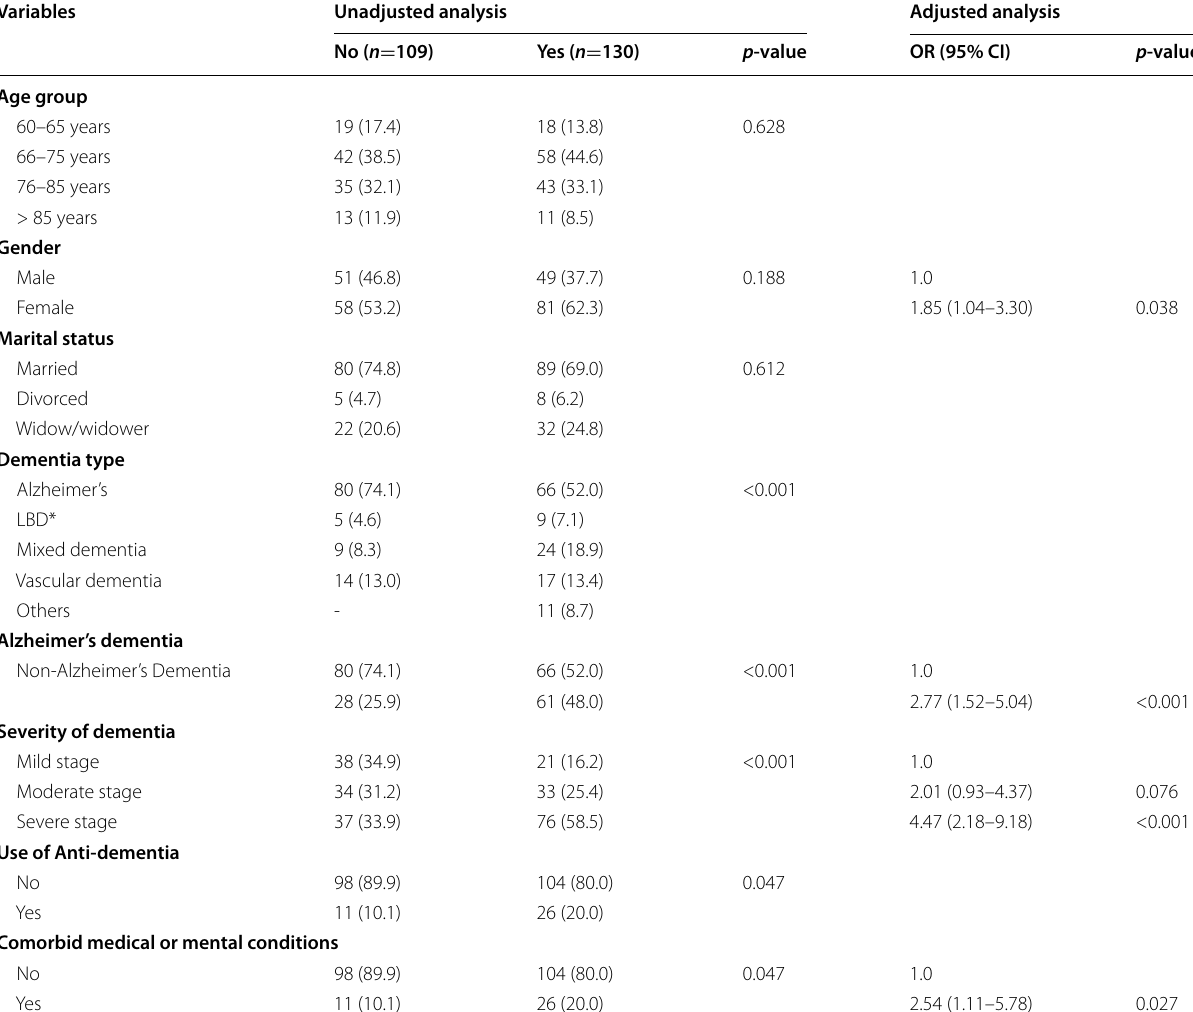
Table 2 Association between demographic, clinical variables, and anti‑psychotic use